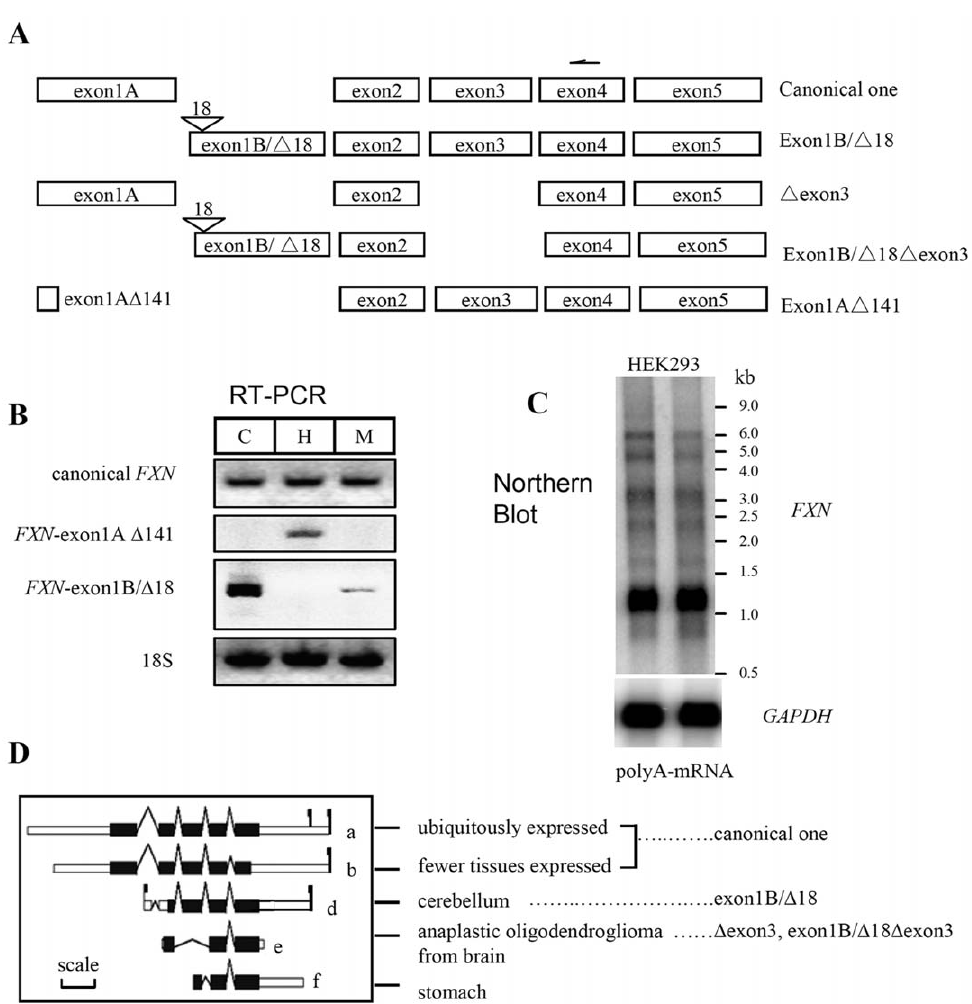
Figure 1. Identification of the diverse transcripts of human FXN. ( A ) Schematic diagram of transcripts of human FXN . One arrow shows the position of the primer for reverse transcription, locating in exon 4 used for 5 9 -RACE with RNA from HEK293 cells. PCR products were sequenced to identify the transcripts. Exon1A is the first canonical exon (only the size of coding region shown); exon1A g 141, exon1A missing the last 141 nucleotides; exon1B, the novel exon 1 locating in the first intron; exon1B g 18, missing 18 nucleotides near the 5 9 -end of exon1B; g exon3, transcript missing exon3. ( B ) Transcripts of human FXN dectected with RT-PCR showed tissue-specific expression pattern. C: cerebellum; H: heart; M: skeletal muscle. ( C ) Diverse transcripts may exist in cells, unveiled by Northern blot. ( D ) Potential FXN transcripts from AceView database, verified when human tissues or cell lines were used. Here are only shown transcripts a, b, d, e, and f. See http://www.ncbi.nlm.nih.gov/IEB/Research/Acembly/av. cgi?c=geneid&org=9606&l=2395. Flagged ones (a,b,d) are annotated to be validated. The correlation between the mRNA identified in this study and those annotated in AceView database is linked by spotted lines. Transcript a and b are not distinguishable and are considered as canonical ones because the primer used for 5 9 -RACE positions within exon 4 of human FXN . Scale: 200